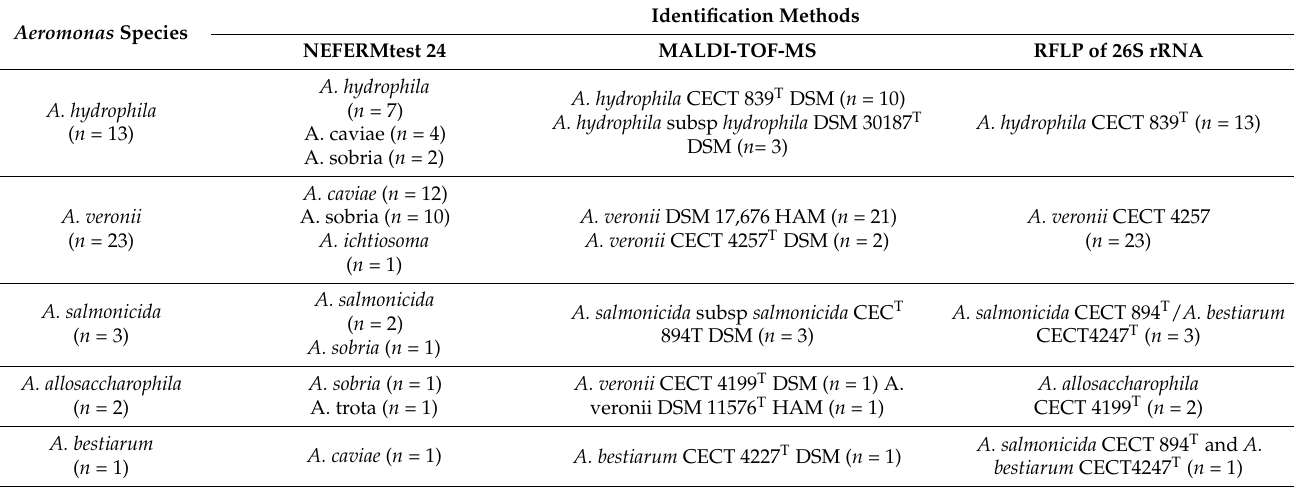
Table 3. Comparison of Aeromonas species identification results.